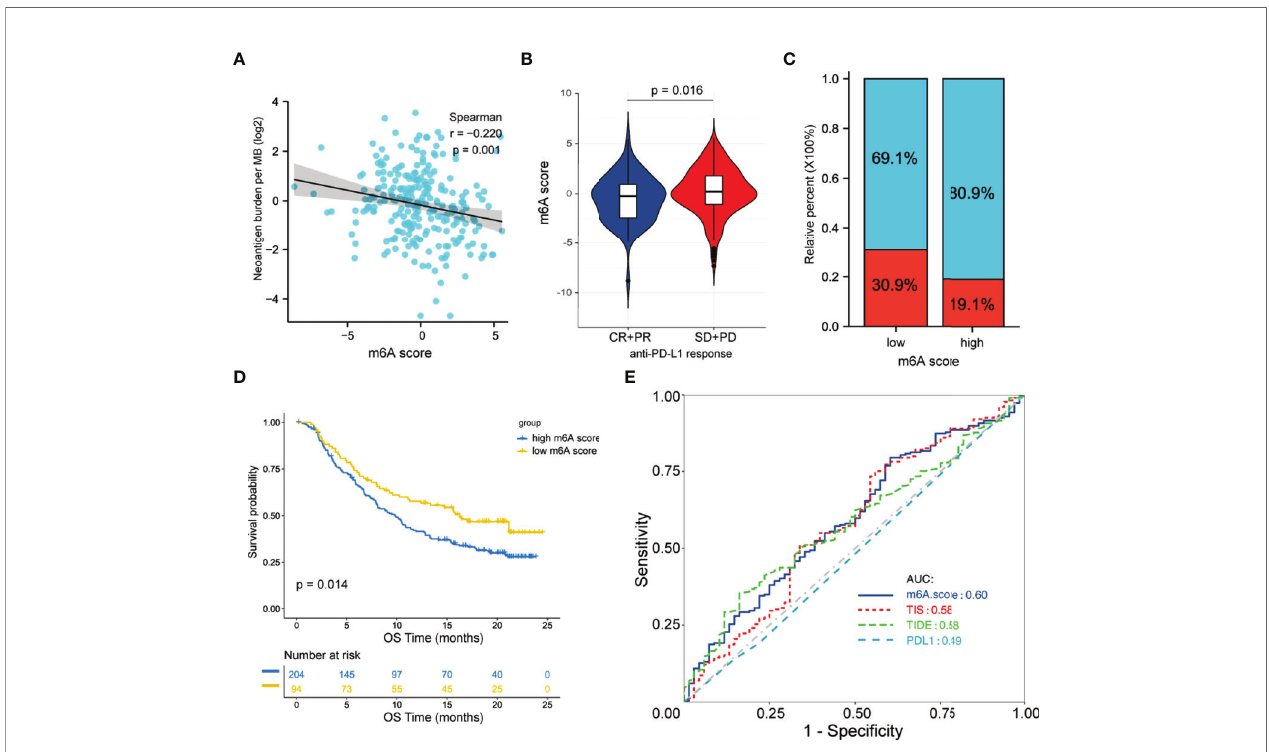
FIGURE 6 | Predictive value of the m6A score for anti-PD-L1 therapy in the IMvigor210CoreBiologies cohort. (A) Correlation between the m6A score and tumor neoantigen burden by Spearman analysis. (B) Differences in the m6A score between patients with different clinical responses. (C) Proportion of patients with clinical response in the low and high m6A score groups. (D) Survival analysis between m6A score groups by the log-rank test. (E) ROC curve analysis for m6A score, TIDE, TIS and PD-L1 expression on tumor cells in predicting the response to anti-PD-L1 therapy. ROC, receiver operating characteristic; TIDE, tumor immune dysfunction and exclusion; TIS, tumor in fl ammation